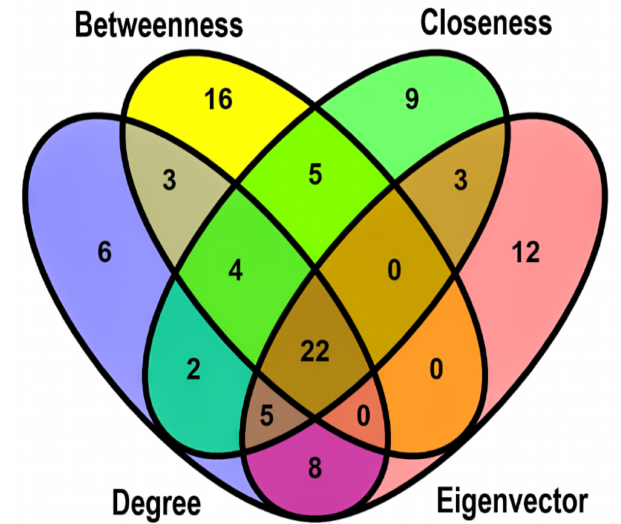
Figure 6. The Venn plot shows 22 overlapping HUBs between the top 50 genes ranked based on four topological algorithms: degree, eigenvector, closeness, and betweenness. The green, yellow, blue, and red areas represent the top 50 genes ranked based on closeness, betweenness, degree, and eigenvector. HUBs, hub genes.